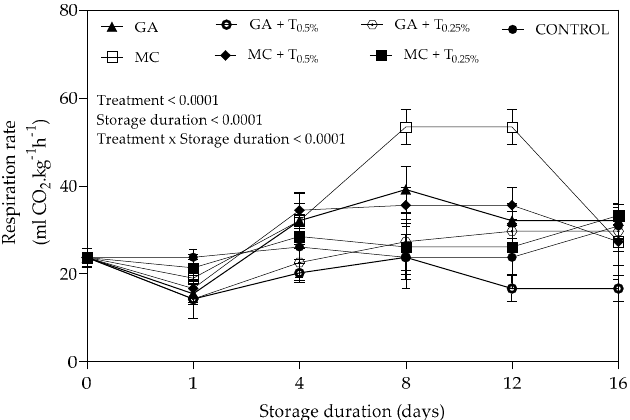
Figure 2. Respiration rate (mlCO 2 kg − 1 h − 1 ) of “Acco” pomegranate arils coated with gum arabic and methyl cellulose coatings enriched with thyme oil (0.5% and 0.25%) and stored at 5 ± 1 °C (95 ± 2% RH) for 16 days. Vertical bars represent the standard error (SE) of mean values of four replicates (1 punnet = 1 replicate). LSD 0.05 represent least significant difference ( p < 0.05).